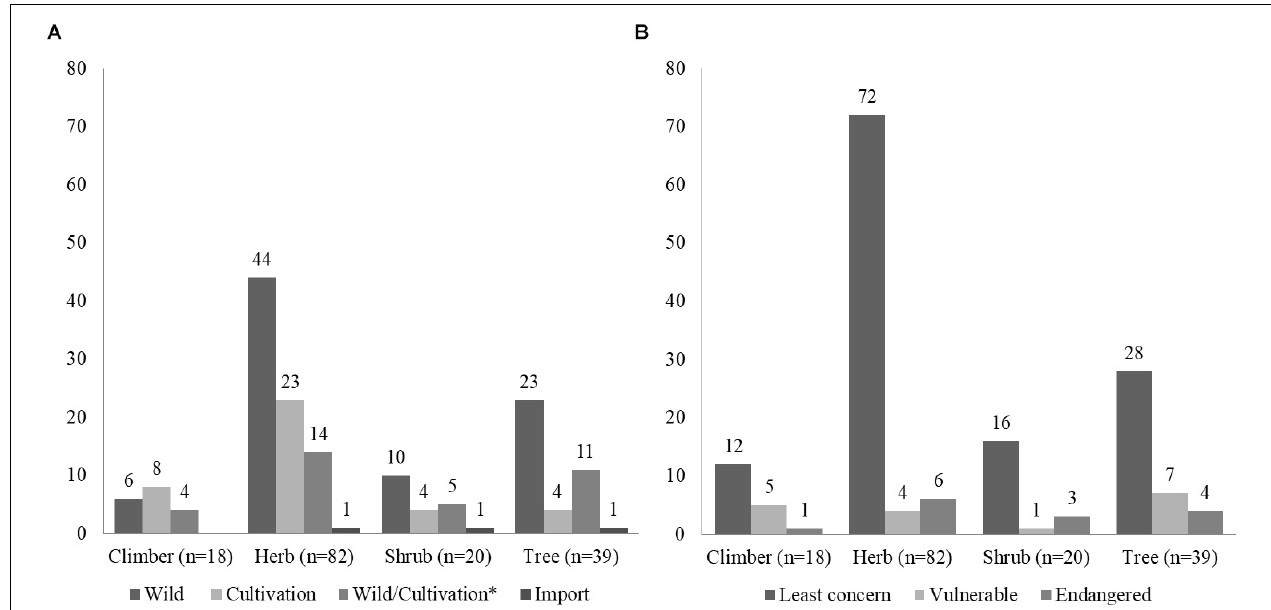
FIGURE 4 | Source and conservation status of species in Ayurvedic products. (A) Source of plants labeled as ingredients in the herbal products studied. (B) Conservation status of plants labeled as ingredients in the herbal products studied. N = total number of species. ∗ Wild/Cultivation denotes that the plants species are sourced both from wild and